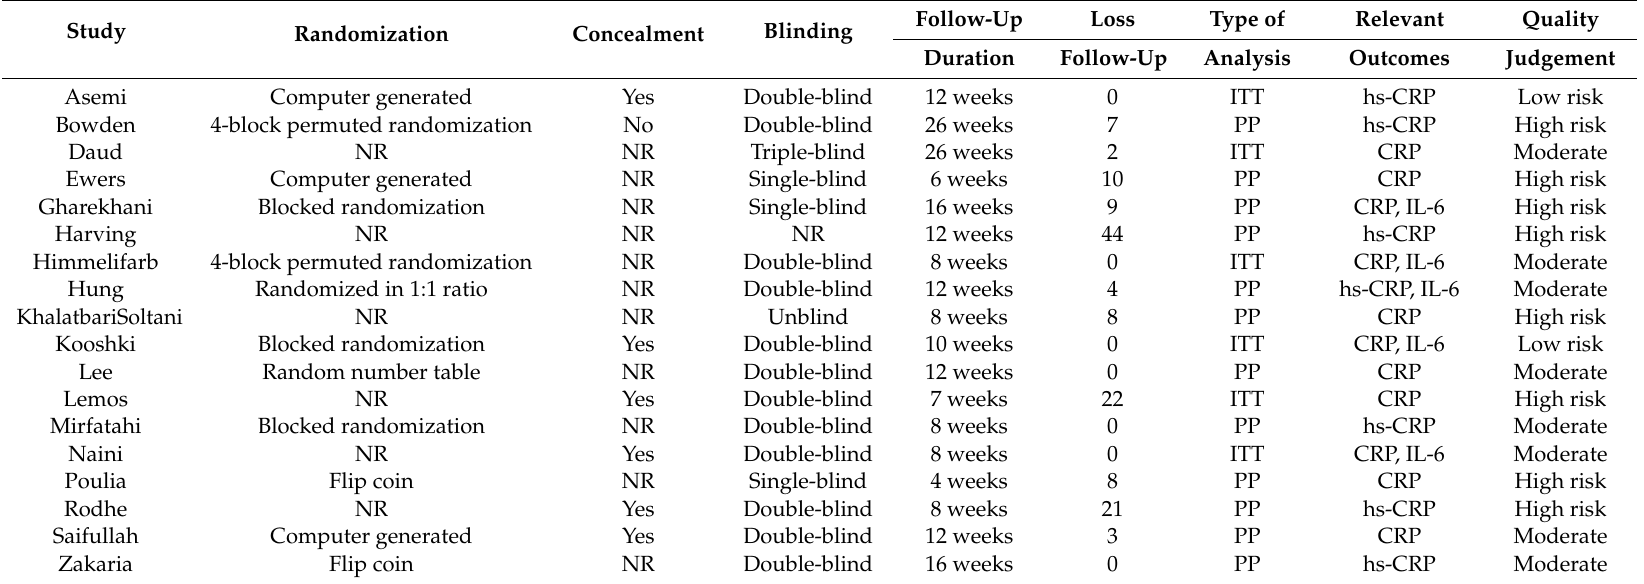
Table 2. Quality of the included randomized clinical